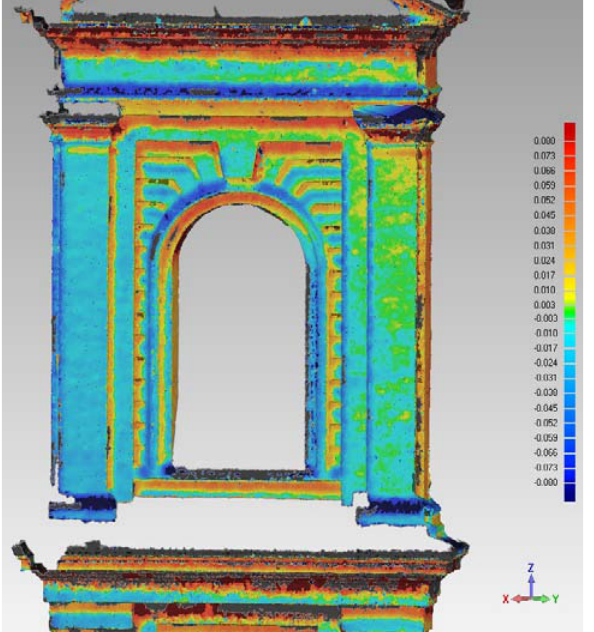
Figure 9. Deviation analysis of a detail of the complex The extreme points of the straight line were identified near corners of the building (unaligned, distant enough, and visible to both systems).